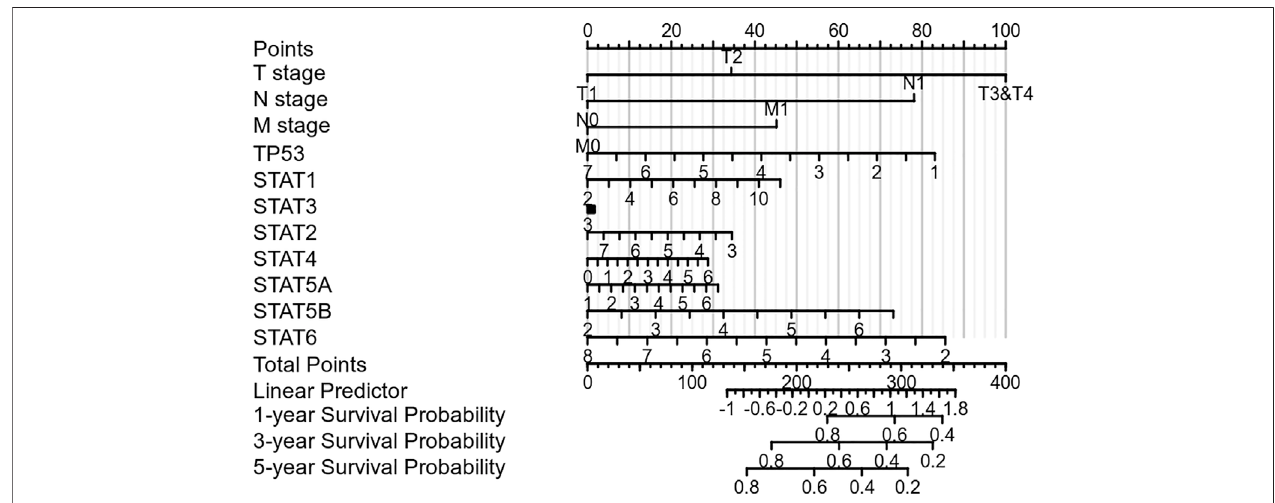
FIGURE 4 | Nomogram integrating the STAT family members and clinical